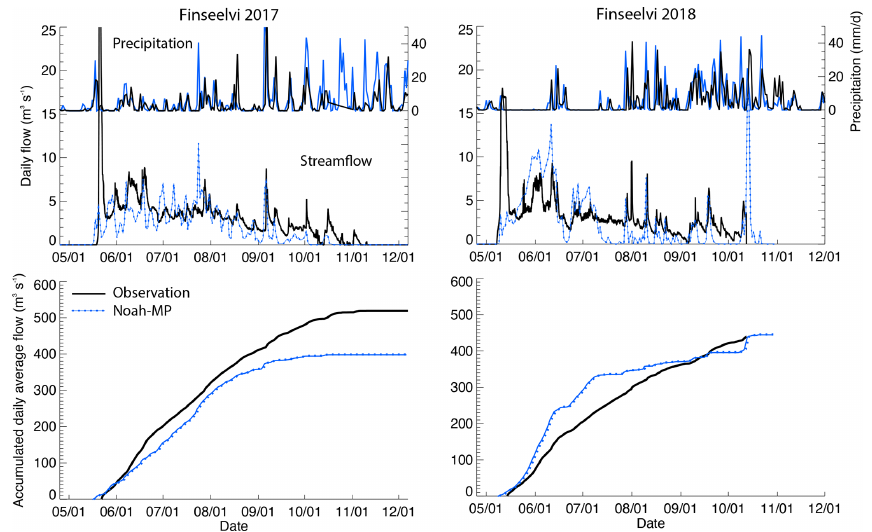
Figure 17. Same as Fig. 16 but for Finseelvi. Note that, in this watershed, the WRF-Hydro/Glacier system is not using Crocus but Noah-MP due to the lack of glaciers.